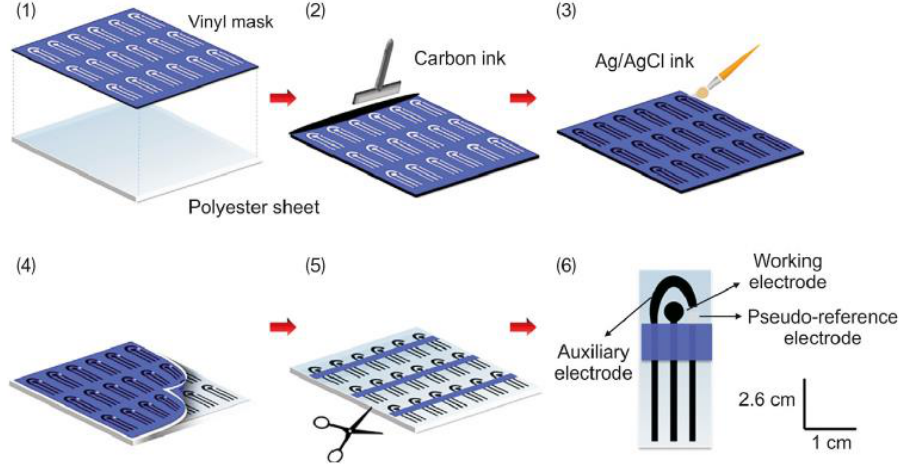
Figure 4. Schematic representation of the preparation of SPE. (1) the vinyl mask was fixed on a polyester sheet (USA Folien Laserjet Clear A4 transparency film); (2) the carbon ink (C2160602D2 from Gwent Electronic Materials Ltd., São Paulo, Brazil) was deposited on the support with a plastic spatula and cured at 90 °C for 30 min; (3) the Ag/AgCl ink (C2051014P10, Gwent Electronic Materials Ltd., São Paulo, Brazil) was applied to the part corresponding to the pseudo-reference electrode, and then the ink was cured at 60 °C for 30 min; (4) removal of the vinyl mask; (5) delimitation of the geometric area of the working electrodes with a rectangular vinyl mask, followed by a heater press and (6) SPE for use. Reprinted with permission from Elsevier from Ref. [48].